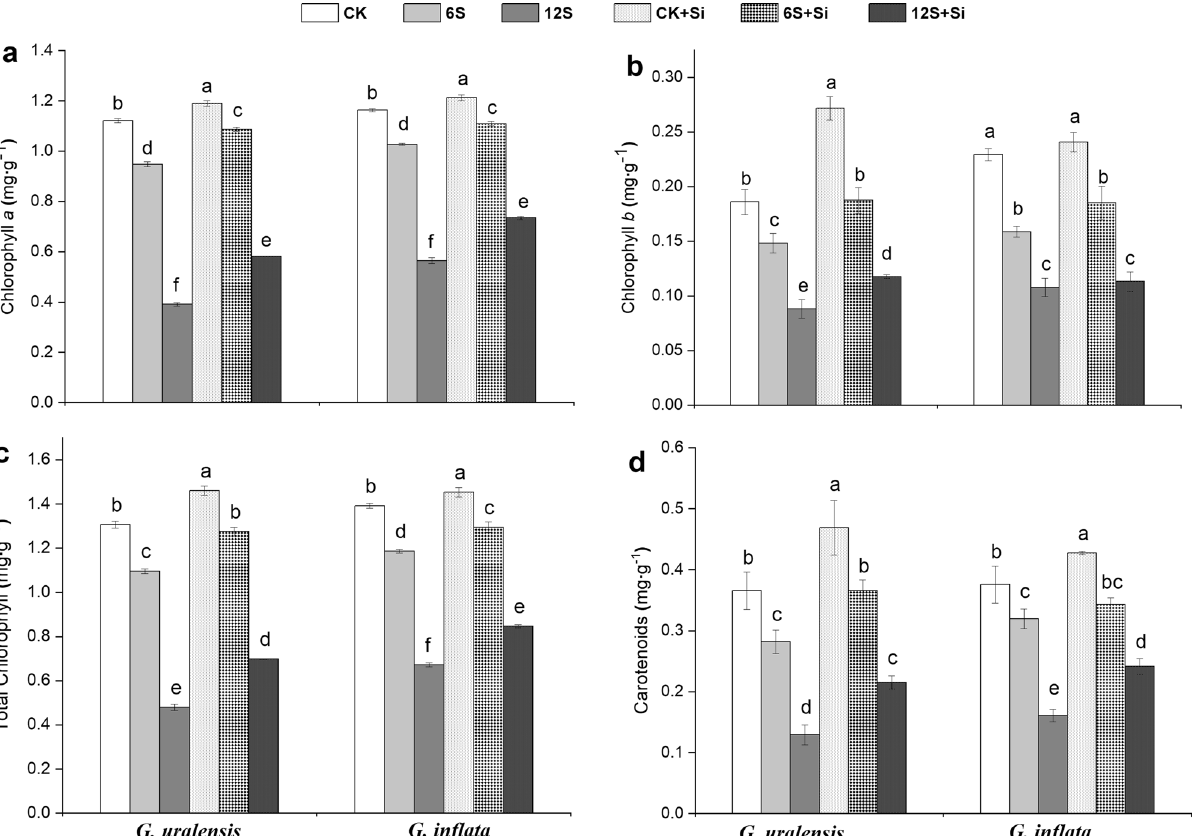
Figure 2. Effects of salinity and Si on chlorophyll a (a) , chlorophyll b (b) , total chlorophyll (c) , and carotenoids content (d) in the two liquorice species. Data are presented as the mean ± SE (n = 3). Different letters indicate significant differences between the values for one index for the same liquorice species under different treatments (P <